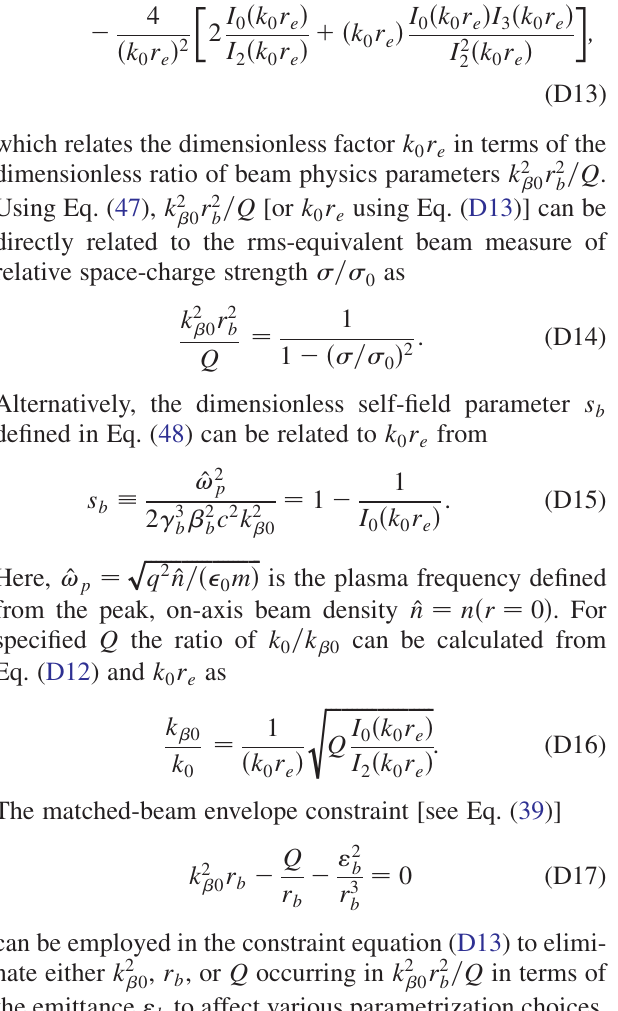
r versus rms- e 0 as calculated from 0